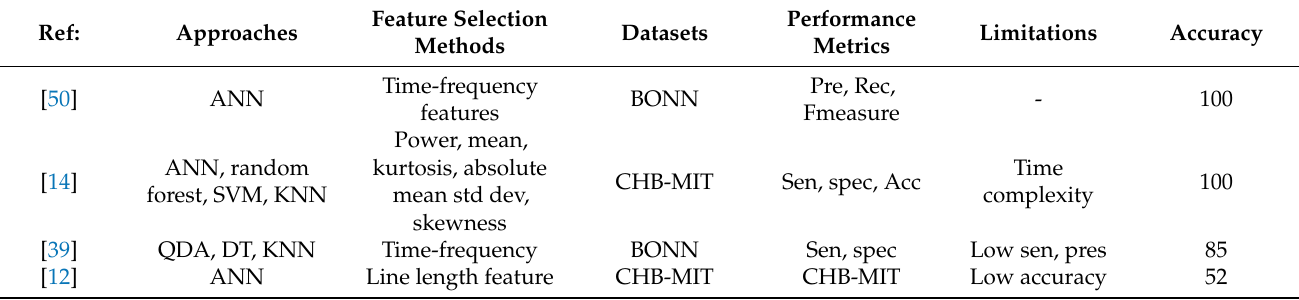
Table 8. A review on ANN approach for seizure